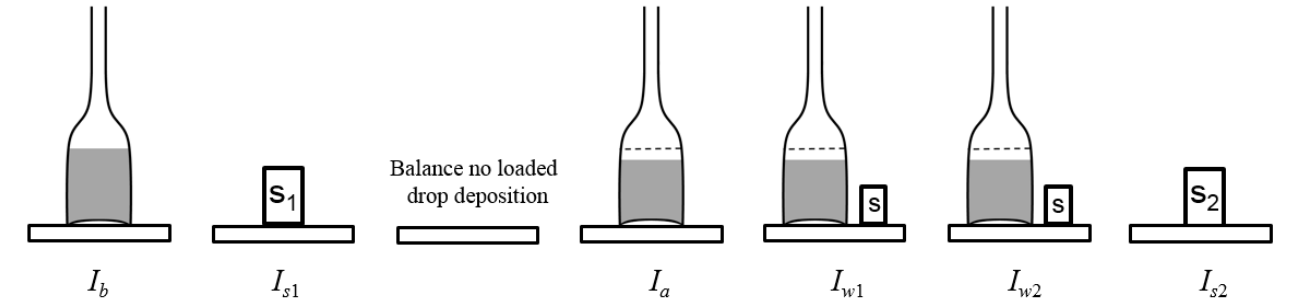
Figure 16. Weighing sequence scheme, with exception between weighing to obtain reading Ia , and Iw 1 balance is zeroed before being loaded.